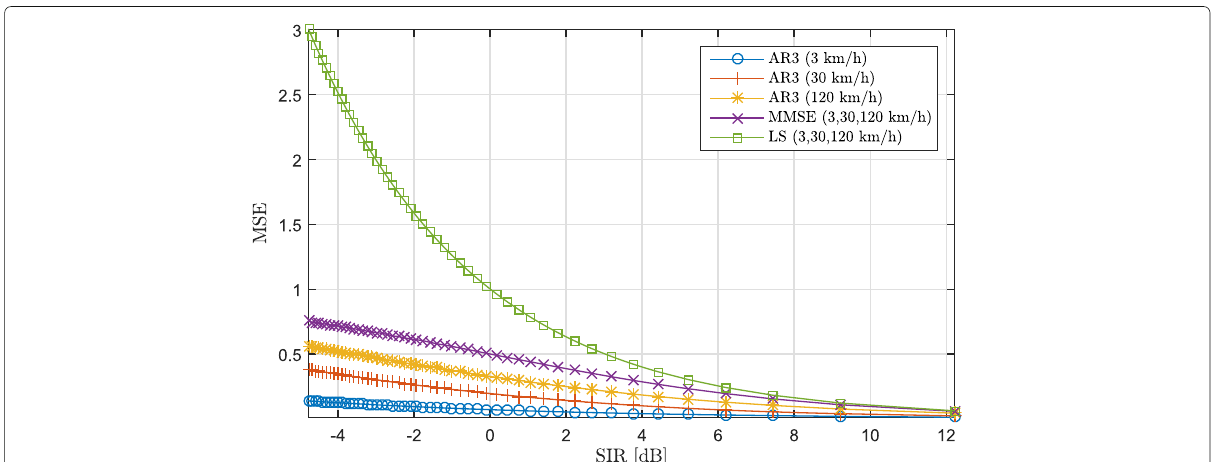
Fig. 11 Comparison between the proposed scheme and conventional solutions with respect to mean squared error as a function of the signal-to-interference ratio